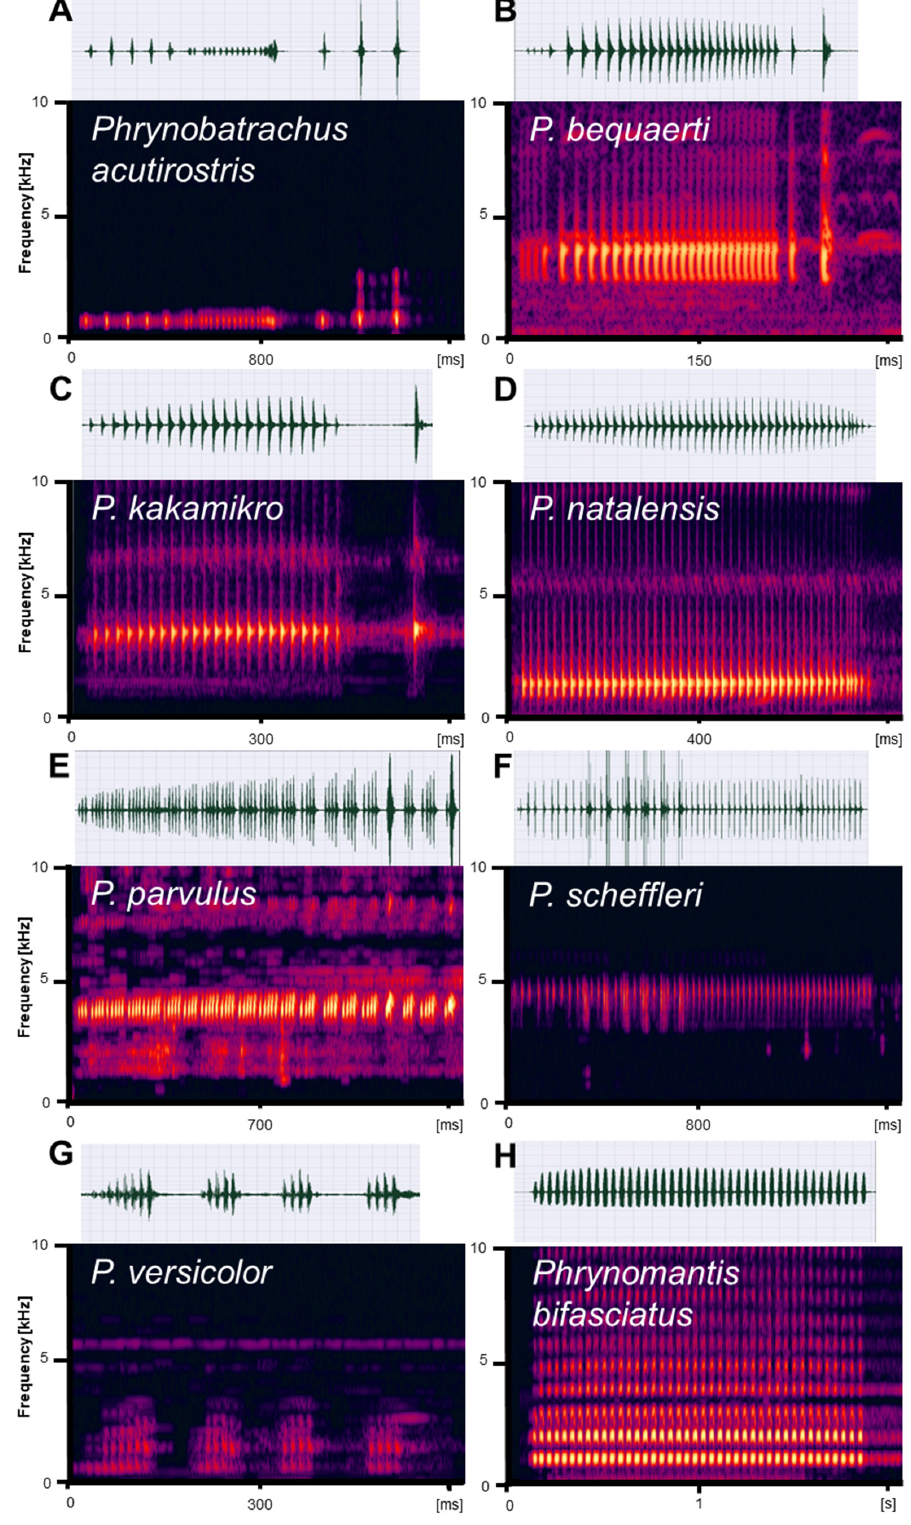
Figure 11. Advertisement calls of Rwandan Phrynobatrachidae ( A ) Phrynobatrachus acutirostris , ( B ) Phrynobatrachus bequaerti , ( C ) Phrynobatrachus kakamikro , ( D ) Phrynobatrachus natalensis , ( E ) Phrynobatrachus parvulus , ( F ) Phrynobatrachus scheffleri , ( G ) Phrynobatrachus versicolor ; and Microhylidae ( H ) Phrynomantis bifasciatus . Calls are shown as representative spectrograms and